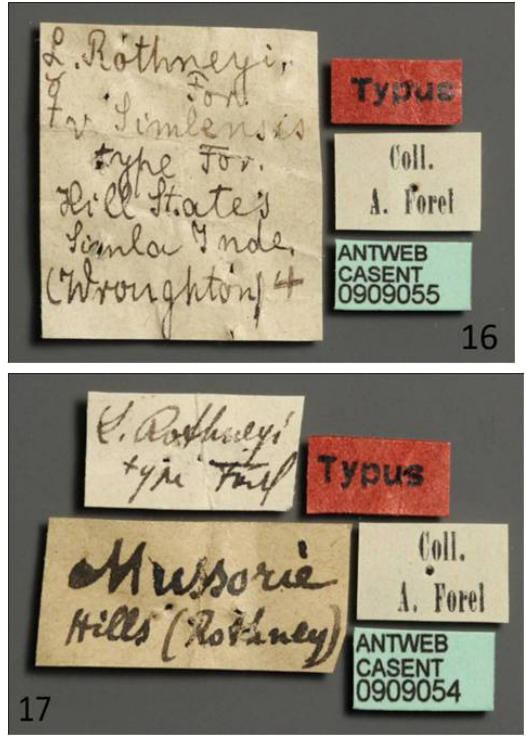
Figs 16, 17 . 16- casent 0909055- T. rothneyi simlensis ; 17- casent 0909054- T. rothneyi .